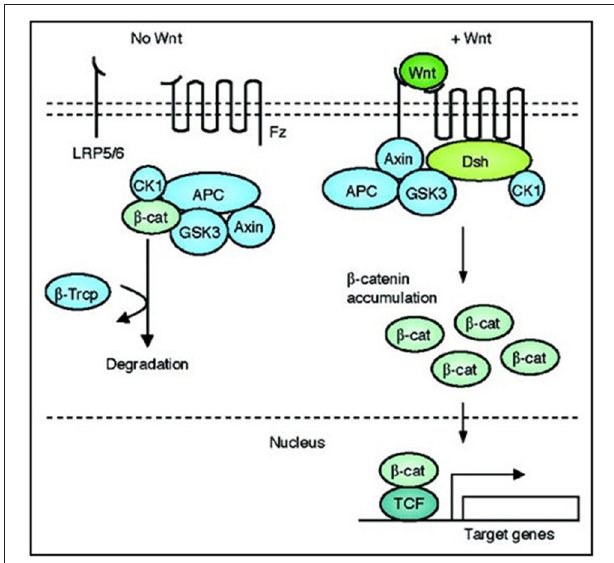
FIGURE 2 | Schematic of the canonical Wnt signaling cascade. Binding of a Wnt ligand to the cell surface causes the translocation of β -catenin to the nucleus and the upregulation of Wnt target genes (